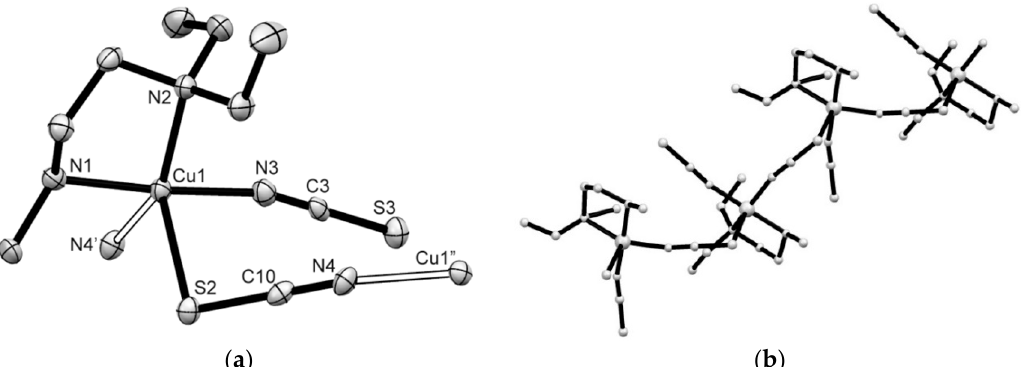
Figure 2. ( a ) Perspective view of the asymmetric unit and the Cu(II) coordination core of 2 (50% probability ellipsoids). Symmetry codes: (‘) x,1/2 − y, − 1/2+z; (“) x,1/2 − y,1/2+z. Selected bond distances (Å) and angles (°): Cu(1)-N(3) 1.957(3), Cu(1)-N(4’) 1.992(3), Cu(1)-N(1) 2.009(3), Cu(1)-N(2) 2.094(3), Cu(1)-S(2) 2.6421(11); N(4)-Cu(1)-N(1) 172.27(19), N(3)-Cu(1)-N(2) 171.9(2). ( b ) View of a section of the polymeric chain of 2